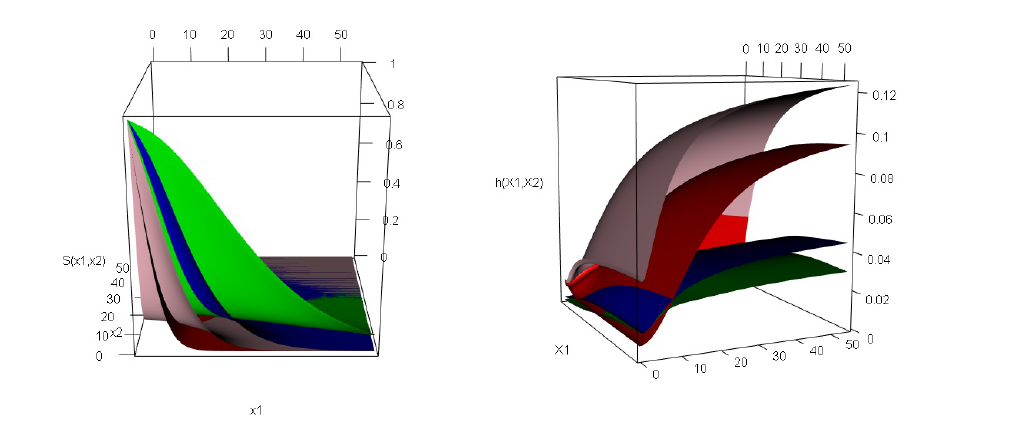
Figure 4 – Survival BXG distribution. Figure 5 – Hazard BXG